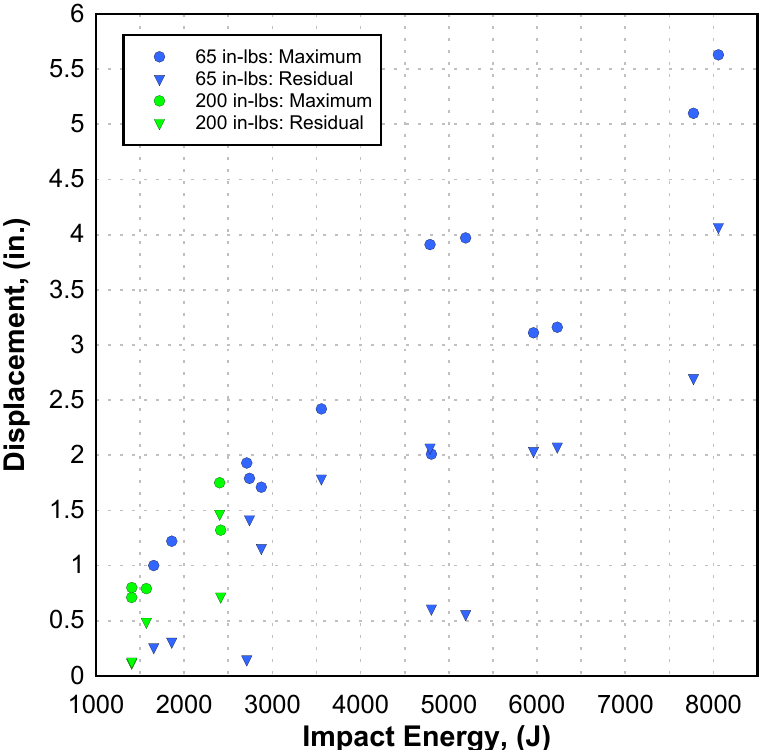
Figure 31. Residual and maximum inbound displacements for three-laminae specimens.